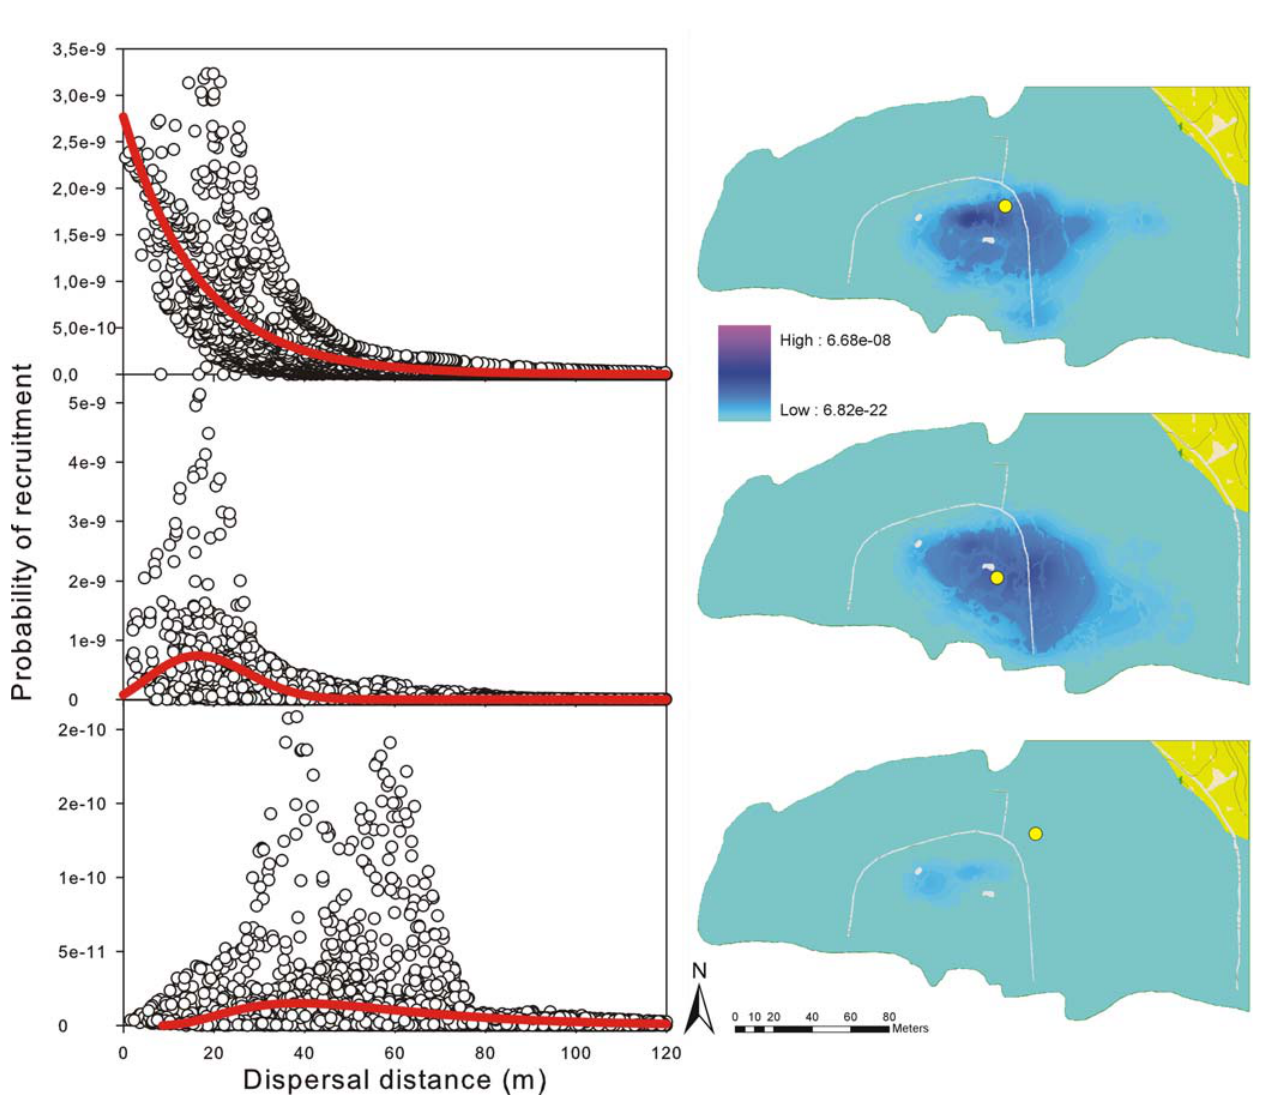
Figure 3. Three types of relationship between dispersal curves and plant recruitment kernels found for the lizard-shrub study system. The three 1D curves and recruitment kernels are selected among those modelled for the 38 plants present in the study area. For each plant, we calculated the combined recruitment kernel provided by the 10 studied lizards (see Figure 2) and subsequently fitted a one-dimensional curve to a sample of 5000 points randomly selected from the modelled recruitment kernel. For a complete list of regression results of 1D fits for the 38 study plants (including individuals 9, 13 and 2, shown here), see Table S11.